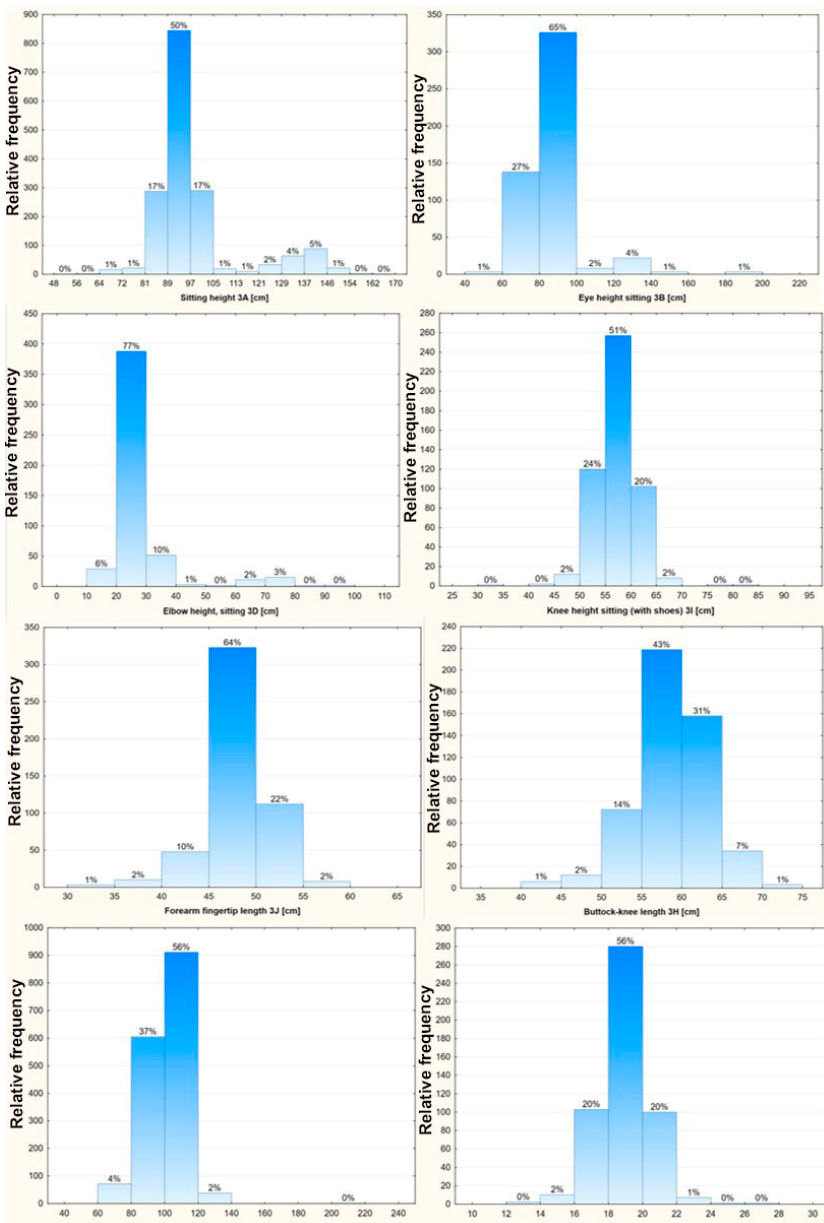
Figure 4. Histograms of analyzed selected anthropometric dimensions for the sitting